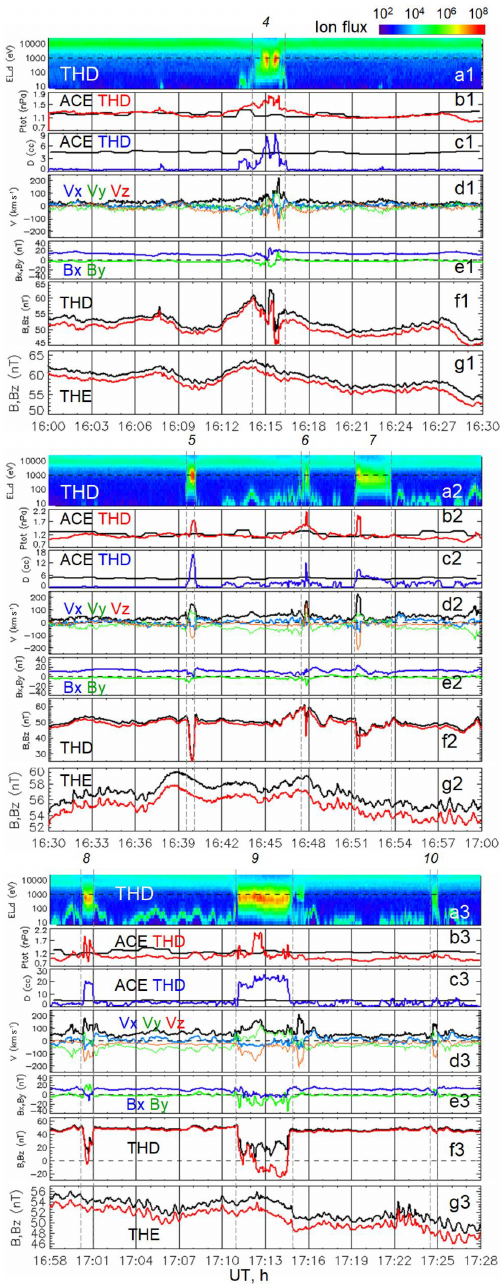
Figure 8. Observations of the plasma and magnetic field during the intervals 16:00–16:30, 16:30–17:00, and 16:58–17:28UT on 1 Au- gust 2008. The panels show from top to bottom: (a) ion spectrogram from TH-D, (b) total pressure P tot measured by the ACE upstream monitor (black) and TH-D (red), (c) plasma density D measured by ACE (black) and TH-D (blue), (d) TH-D measurements of bulk ve- locity V (black) and its components in GSM coordinates V x (blue), V y (green), and V z (red), (e) transversal components of magnetic fields B x (blue) and B y (green) from TH-D, (f) magnitude B and B z components of the magnetic field from TH-D, and (g) magni- tude B and B z components of the magnetic field from TH-E. The magnetosheath plasma penetration is denoted by dashed lines and numbers 4–10.